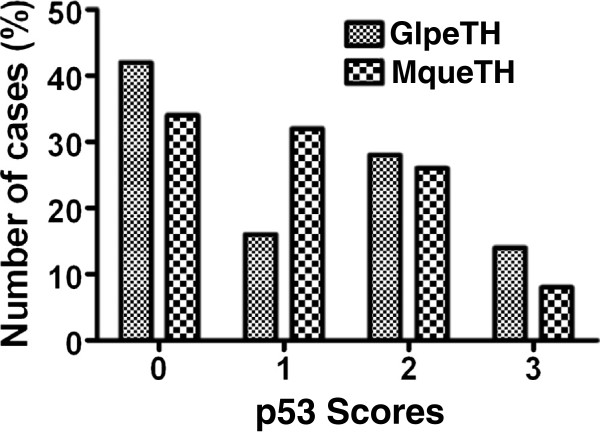
p53 staining analysis using a scoring method based on nuclear staining intensity. (0) negative staining, (1) weak staining, (2) moderate staining, (3) strong staining.